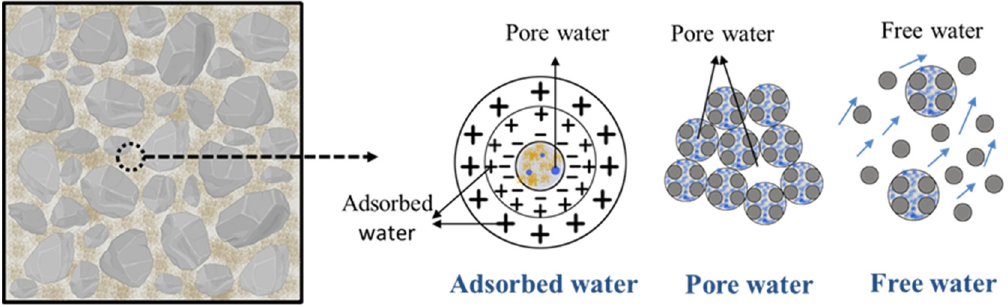
Figure 3. LF-NMR instrument.